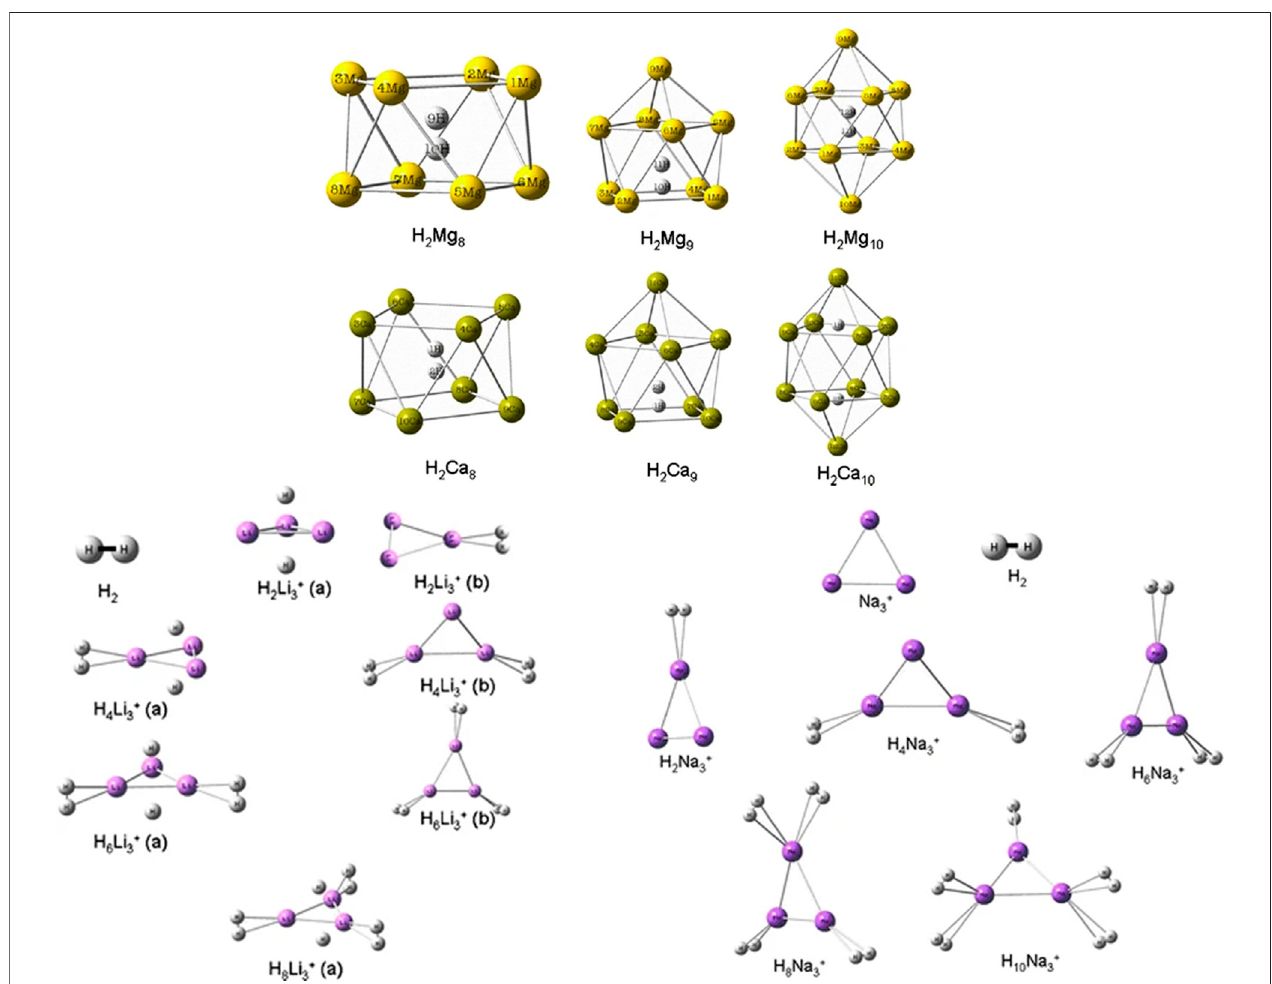
FIGURE 1 | Optimized geometries of H 2 M n (M (cid:1) Mg, Ca; n (cid:1) 8 – 10), x H 2 -trapped Li 3+ , and y H 2 -trapped Na 3+ clusters at B3LYP/6 – 311 + G(d) level of theory (Reproduced with permission from Springer Nature Customer Service Centre GmbH: Journal of Molecular Modeling (Giri et al., 2011a), Copyright © 2010, Springer-